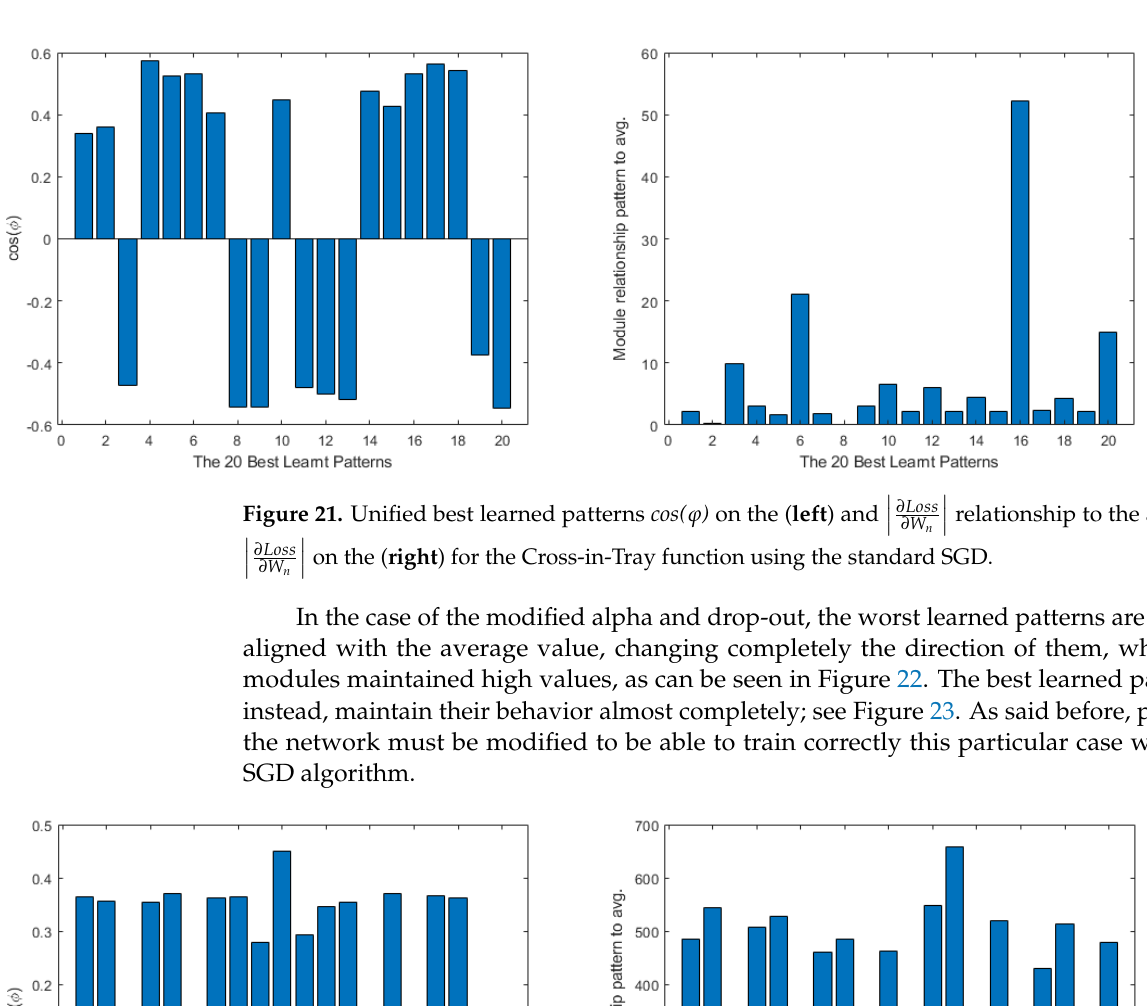
Figure 22. Unified worst learned patterns cos(φ) on the ( left ) and | 𝜕𝐿𝑜𝑠𝑠 𝜕𝑊 𝑛 | on the ( right ) for the Cross-in-Tray function using the dynamic alpha and drop-out.